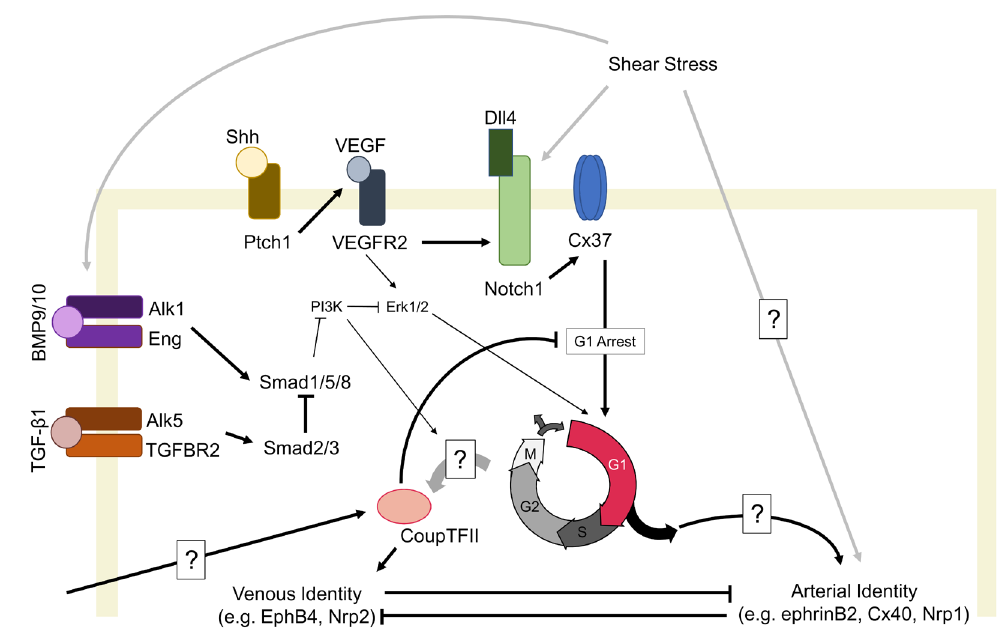
Figure 1. A proposed model of the regulation of arteriovenous specification in primitive endothelial cells, highlighting key players and some of the evidence of cell signaling cross-talk.